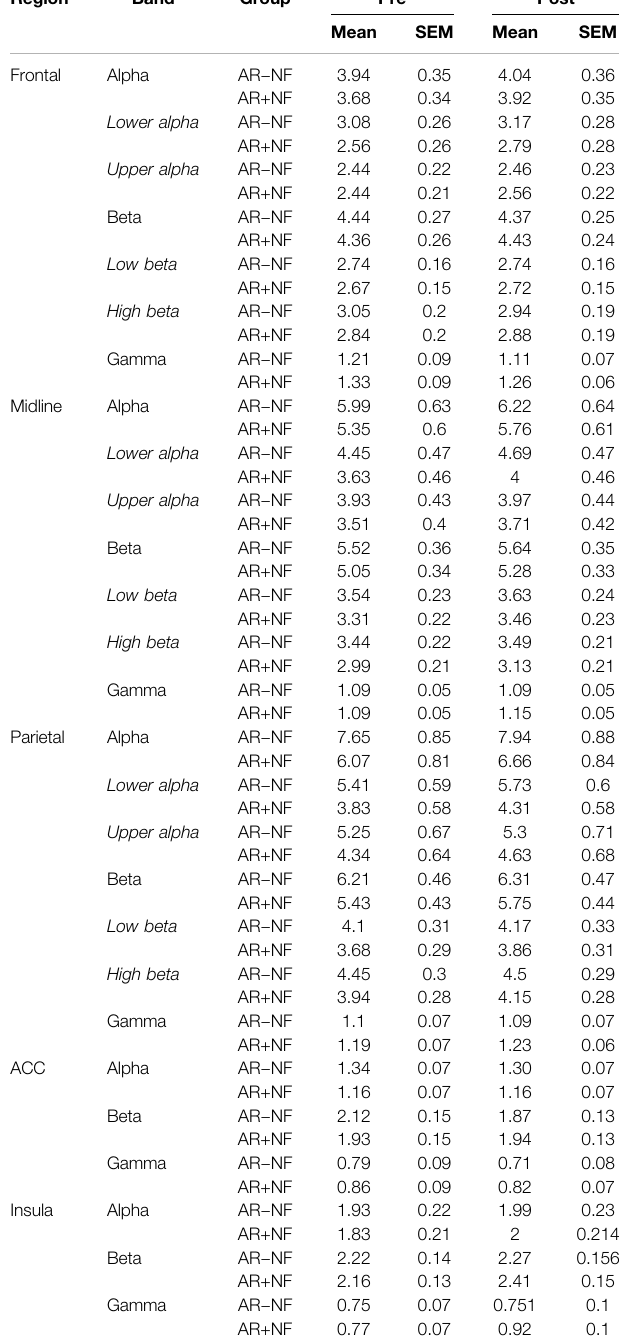
TABLE 3 | Means and standard error estimates of EEG variables pre and post AR